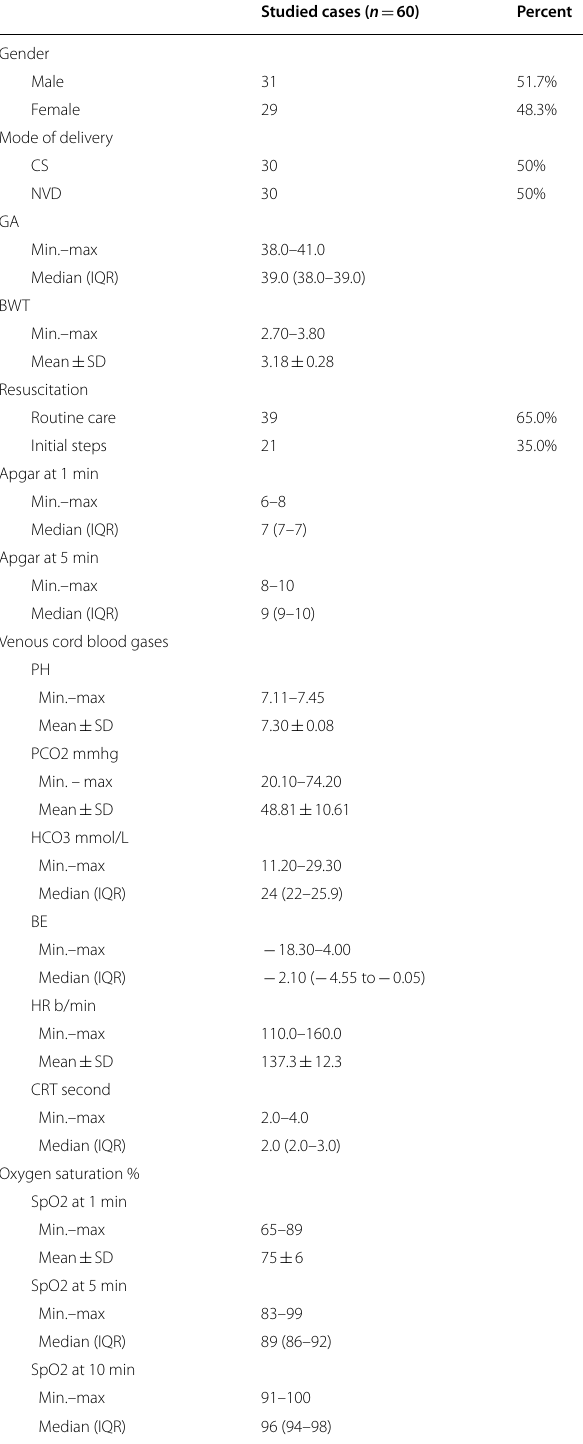
Table 1 Descriptive analysis of the studied cases according to demographic, resuscitation, venous cord blood gases and clinical